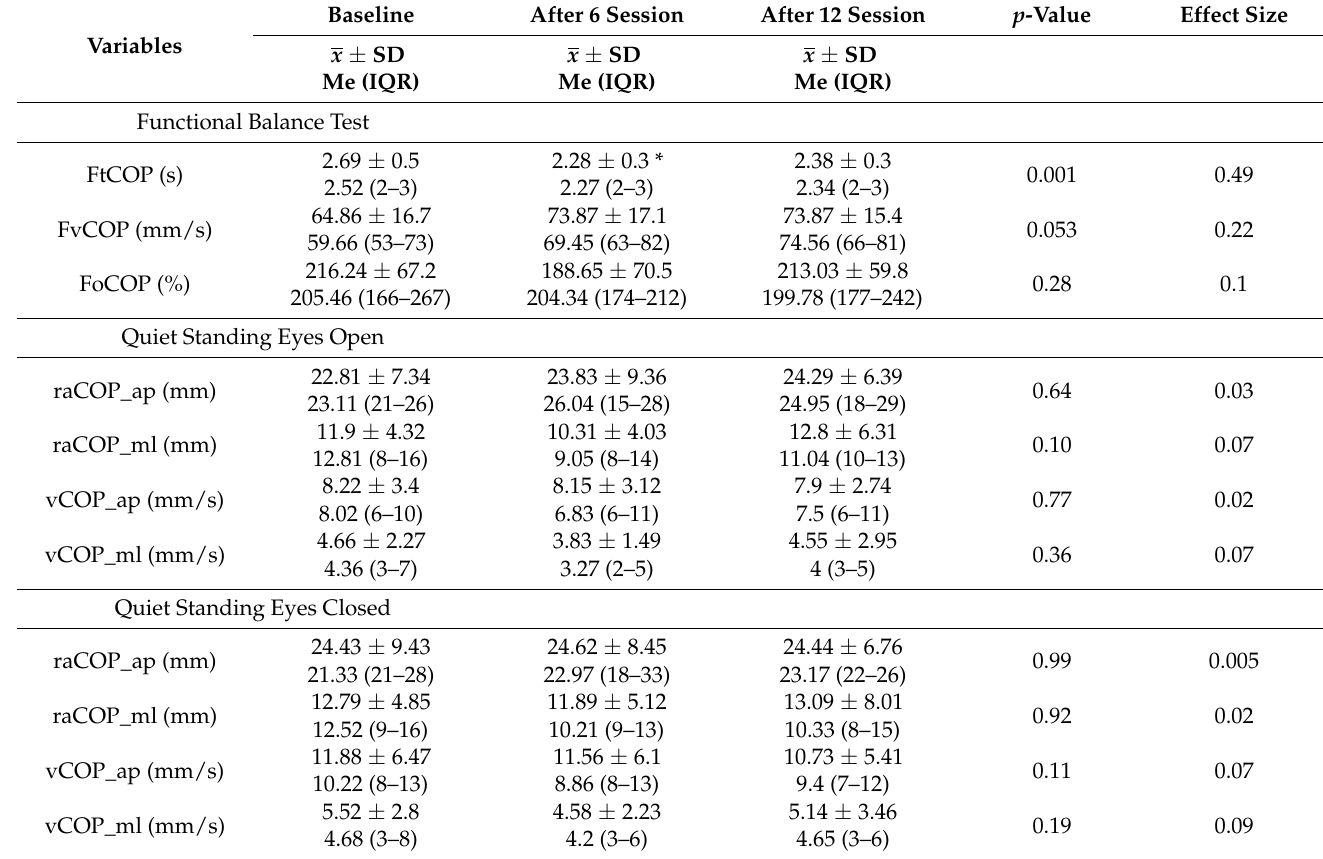
Table 1. The results of the functional balance test and quiet standing